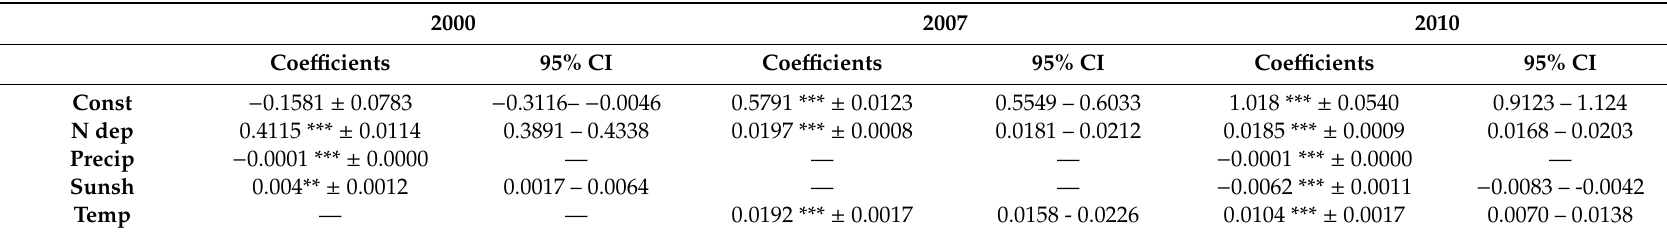
Table 8. Regression coe ffi cients with heteroscedasticity-consistent standard errors for croplands. Const: Constant, N dep: N deposition (natural logarithm of N deposition only used in 2000), Temp: Temperature, Precip: Precipitation, and Sunsh: Sunshine. ** Statistically significant p < 0.01. *** Statistically significant p < 0.001.